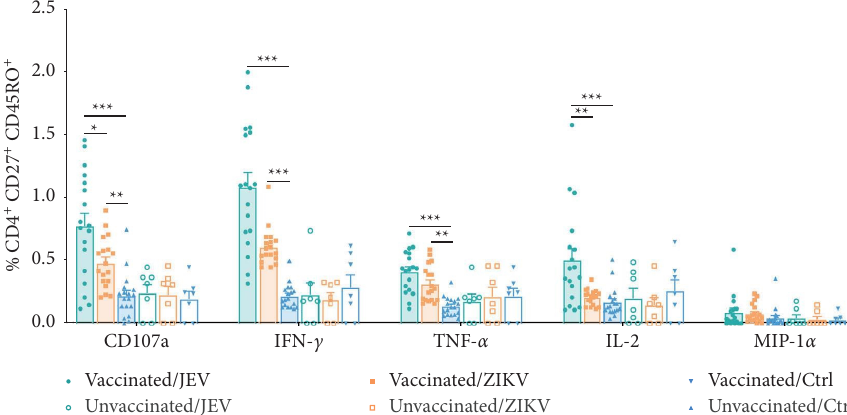
Figure 3: Multifunctional characterization of CD4 + , CD27 + , CD45RO + central memory Tcell (T subpopulations were gated on cells expressing at least one of the fve Tcell functions analyzed, and the frequency of cells expressing any of the fve cell functions was assessed. Vaccinated, n � 18; unvaccinated, n � 7. Results are expressed as mean ± SD. Diferences between unmatched groups were compared using an unpaired t -test, the Mann–Whitney U test, or the Kruskal–Wallis rank-sum test with Dunn’s post hoc test for multiple comparisons. ∗ P < 0 . 05, ∗∗ P < 0 . 01, and ∗∗∗ P < 0 . 001.